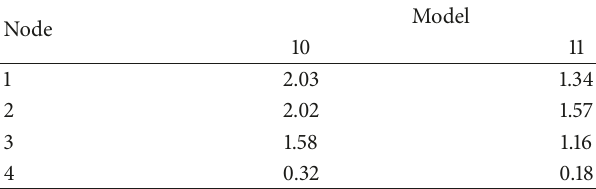
Table11:Maximumdisplacements(mm)elicitedbythetwomodels.